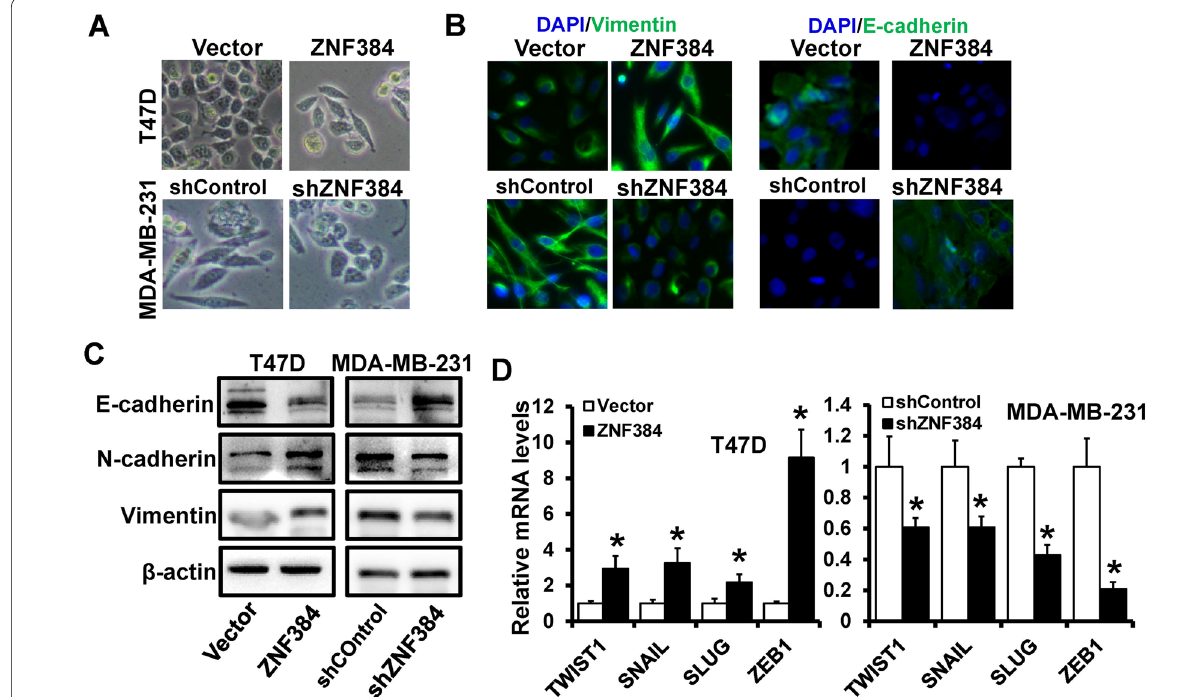
Fig. 4 ZNF384 induces an EMT‑like phenotype in breast cancer cells. A Representative images of morphology in ZNF384‑overexpressed T47D cells or ZNF384‑depleted MDA‑MB‑231 cells, as well as control cells. B, C The expression of epithelial marker (E‑cadherin) and mesenchymal markers (Vimentin and N‑cadherin) in cells as in A is determined by immunofluorescence ( B ) and western blot ( C ). D The expression of EMT‑related transcriptional factors in cells as ( A ) determined by RT‑qPCR. * P <